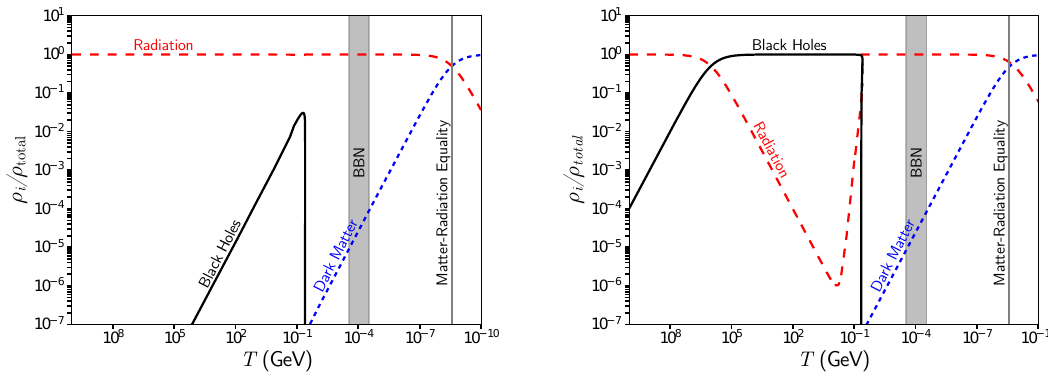
Figure 2 . Two examples of the evolution of the energy density in SM radiation, primordial black holes, and dark matter, which is produced through Hawking evaporation. In each frame, we have adopted an initial black hole mass of M i = 10 8 g. In the left frame, we show results for the case of 10 − 14 at T i = 10 10 GeV, and a dark matter particle mass an initial black hole density of f i = 8 × of m DM = 10 9 GeV. In the right frame, the black holes come to dominate the energy density of the 10 10 universe, and we have chosen m DM = 6 ×